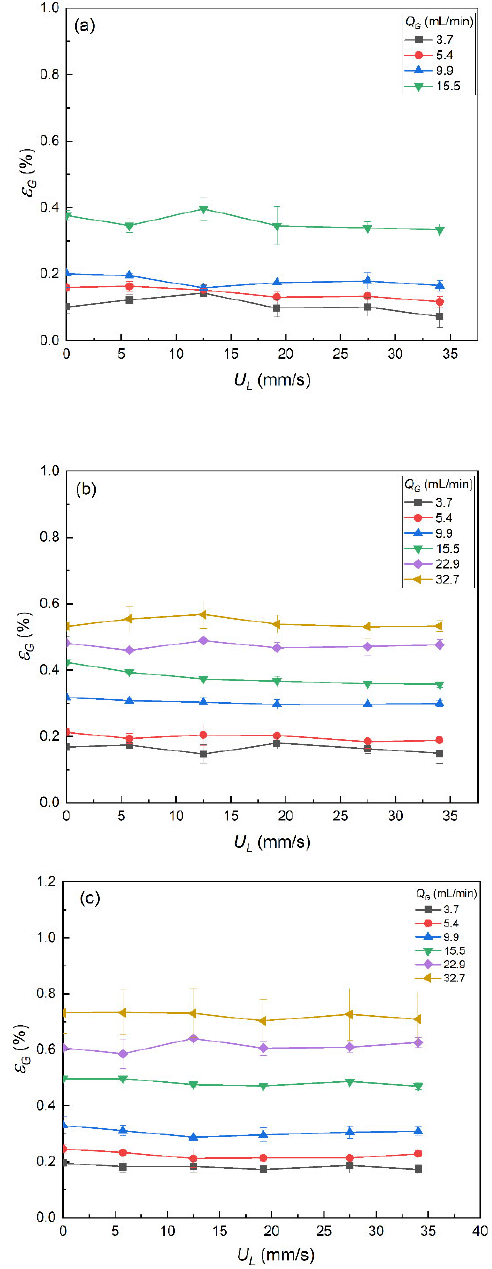
Figure 7. Characterization of gas volume fraction, ε G as a function of gas flowrate, Q G and liquid velocity, U L with different gas sparger sizes: ( a ) d G = 50 μ m, ( b ) d G = 100 μ m, ( c ) d G = 150 μ m.